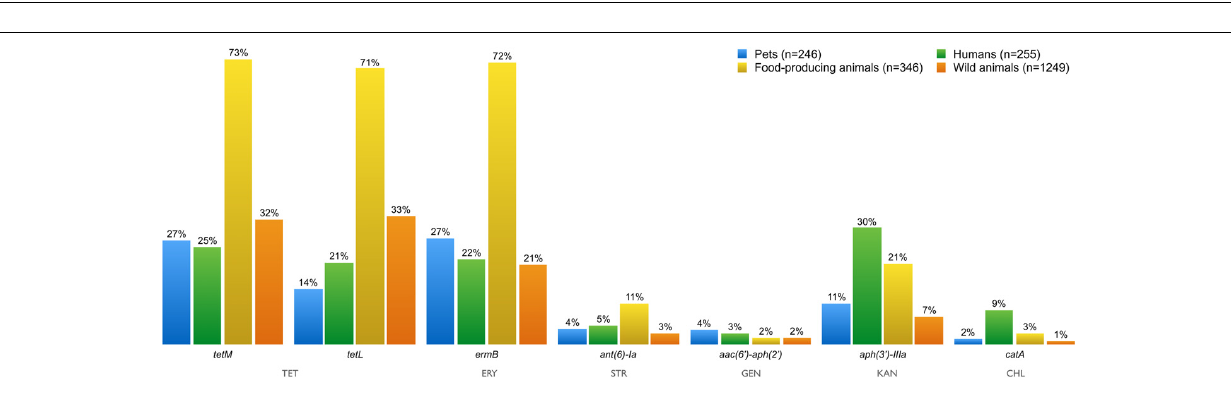
Frontiers in Microbiology |